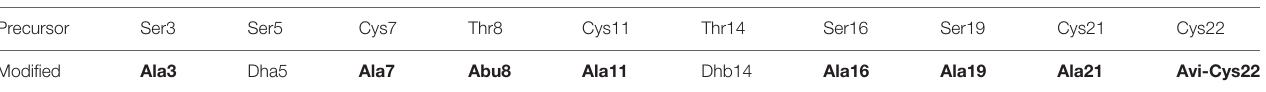
TABLE 1 | Amino-acid sequence of the core peptide precursor and post-translationally modified MU1140.